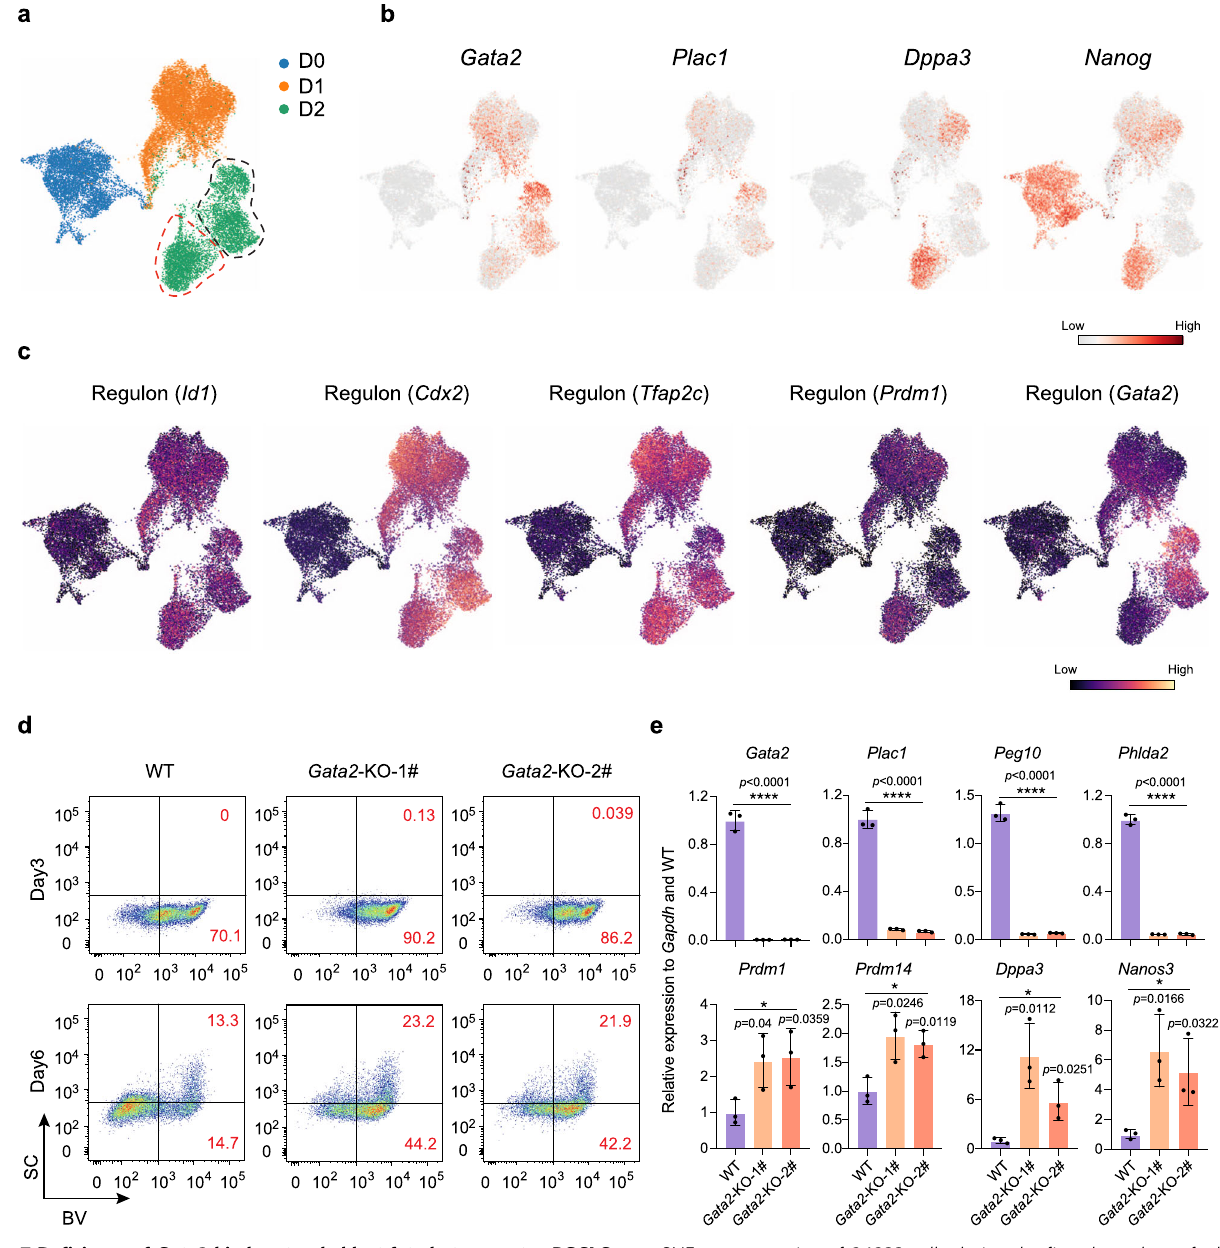
Fig. 7 De fi ciency of Gata2 hinders trophoblast fate but promotes PGCLCs. a t-SNE representation of 24233 cells during the fi rst three days of whole process, colored by time point of samples. The cells enclosed by red and black dotted lines indicate two distinct populations. b Cells colored by expression pattern of Gata2 , Plac1 , Dppa3 , and Nanog in t-SNE representation. c t-SNE plot displaying Id1 , Cdx2 , Tfap2c , Prdm1 and Gata2 regulons (red dots, active; black dots, inactive) in the fi rst 3 days, respectively. d FACS analysis of BVSC induction at Day 3 and Day 6 during BiPNT in WT or two independent Gata2 -KO EpiSCs. e RT-qPCR analysis for expression of trophoblast and PGC associated genes in WT and two Gata2 -KO cells from Day 6 of BiPNT. Data are mean ± s.d., two-tailed, unpaired student ’ s t -test; n = 3 independent experiments. * p < 0.05, **** p < 0.0001. n = 3 independent experiments. Source data are provided as a Source Data fi with BD FACSAria III (BD Biosciences). The FACS data were analyzed with medium and changed daily for the fi rst 3 days. The Stage 2 medium was refreshed FlowJo 10.4 software. daily for the last 5days. The following antibodies were used: APC anti-c-Kit (eBioscience, 17-1171- 83,1:200), Alexa Fluor 647 anti-mouse/human CD15 (SSEA-1) (BioLegend, 125607, 1:200), PE anti-mouse/rat CD61 (BioLegend, 104307, 1:500). Flow cytometry . Cells were dissociated with 0.05% Trypsin-EDTA and neutralized with DMEM containing 10% FBS. After the dissociation, cells were collected by centrifugation and resuspended with fl ow cytometry buffer (DPBS with 0.1% BSA Immuno fl uorescence . The cells were seeded on coverslips and the fi xed with 4% and 1mM EDTA) at a density of 1× 10 6 cells per 100 μ l buffer. Cells were then paraformaldehyde for 30 min at room temperature. The cells were washed with incubated with fl uorophore-conjugated antibodies for 30 min at 4°C. After incu- PBS once and subsequently soaked in the mixing buffer of equal volume of 0.1% bation, cells were washed with DPBS for three times, resuspended with fl ow Triton X-100 and 3% BSA for 1h at room temperature. The cells were washed with cytometry buffer, and fi ltered with 40 μ m cell strainer to remove large clumps of PBS once, then incubated with primary antibody at 4 °C for overnight. The cells cells. Cells were then analyzed with LSR Fortessa X-20 (BD Biosciences) or sorted were washed with PBS fi ve times next day, then incubated with appropriate